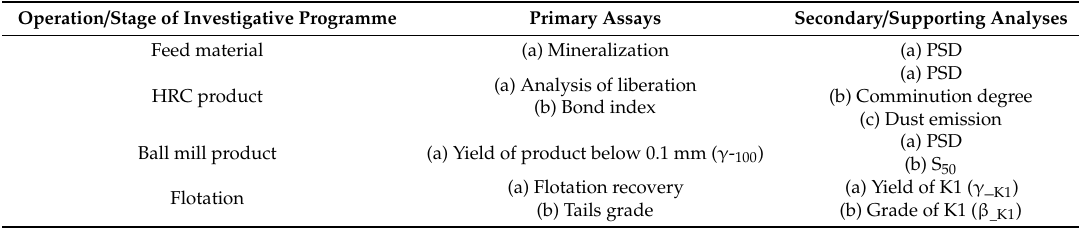
Table 2. List of analyses carried out in research